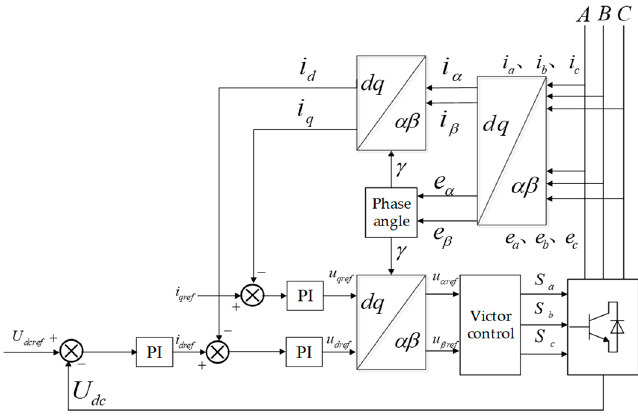
Figure 2. A diagram of the vector decoupling control method.